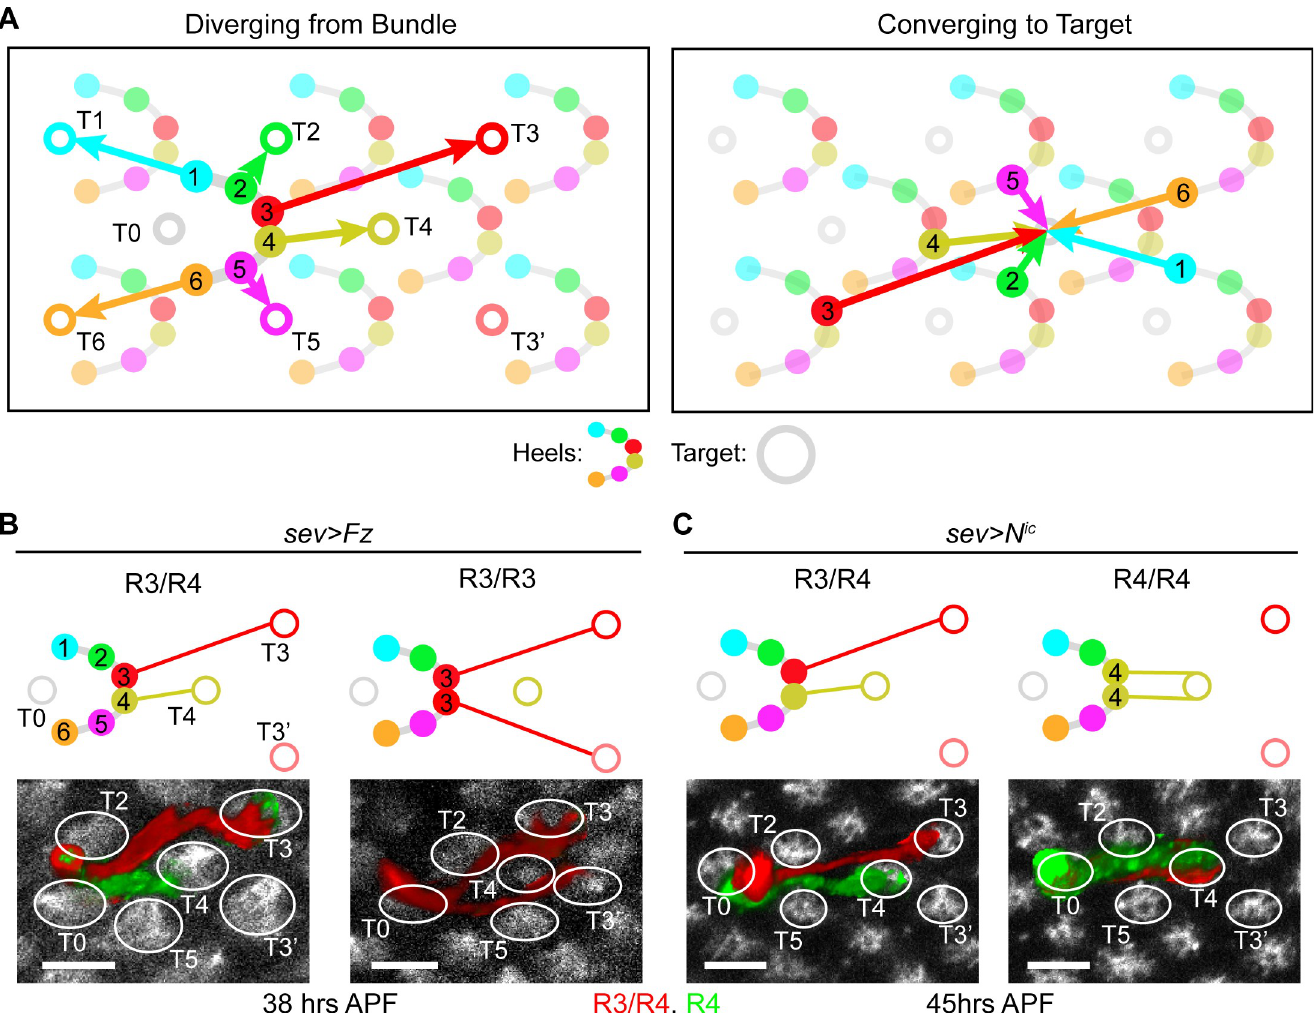
Fig 1. Changes in R3 or R4 cell identity lead to changes in final targeting. (A) Schematic of NSP wiring topology. Solid circles: Landing points of R1-R6 at the lamina (“heels”); open circles: target locations of R1-R6 growth cones. T3’: target of fate-transformed R3s; T0: target located within the bundle of interest (though targeted by R cells from other bundles in NSP wiring). R1-R6 are color coded consistently in all schematics. (B-C) Representative schematics and images of bundles from (B) sev > Fz (38 hrs APF) and (C) sev > N ic (45 hrs APF) flies (see S1B and S1C Fig for more examples). Top panels: schematics of wild-type or altered wiring topology. Bottom panels: confocal images of representative bundles. Photoreceptor growth cones were segmented, pseudo-colored, and intensity scaled for visualization (Materials and Methods). Red: sev > RFP expression; green: m δ 0 . 5-GFP expression; white: Fasciclin 2 (FasII) antibody staining. White ellipses: targets. Scale bar: 5 μ